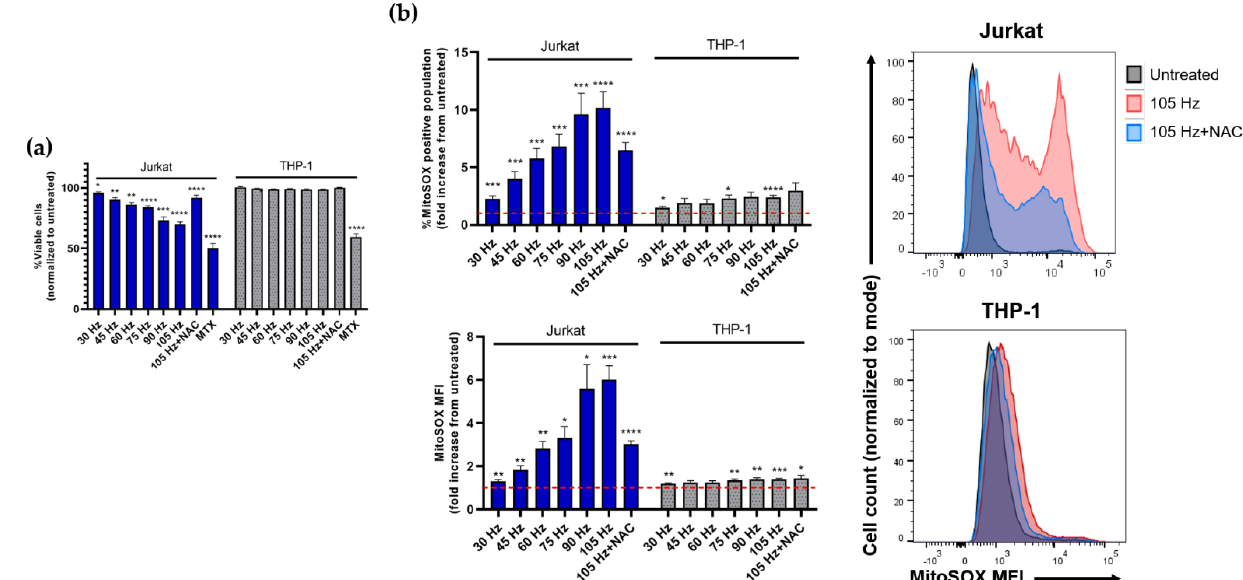
Figure 3. NTP induces cytotoxicity in Jurkat cells but not in THP-1 in a frequency-dependent manner up to 105 Hz. ( a ) Viability of Jurkat and THP-1 cells 24 h post NTP exposure. ( b ) Mitochondrial superoxide production increased in both Jurkat and THP-1 cells 24 h post-NTP exposure, measured both as percent MitoSOX-positive cells and overall mean fluorescence intensity (MFI). Dotted line indicates no change with respect to cells not exposed to NTP. Data are presented as mean ± SEM. Significance was calculated using Brown–Forsythe one-way ANOVA and Dunnett’s post-hoc test (* p < 0.05, ** p < 0.01, *** p < 0.001, **** p < 0.0001).